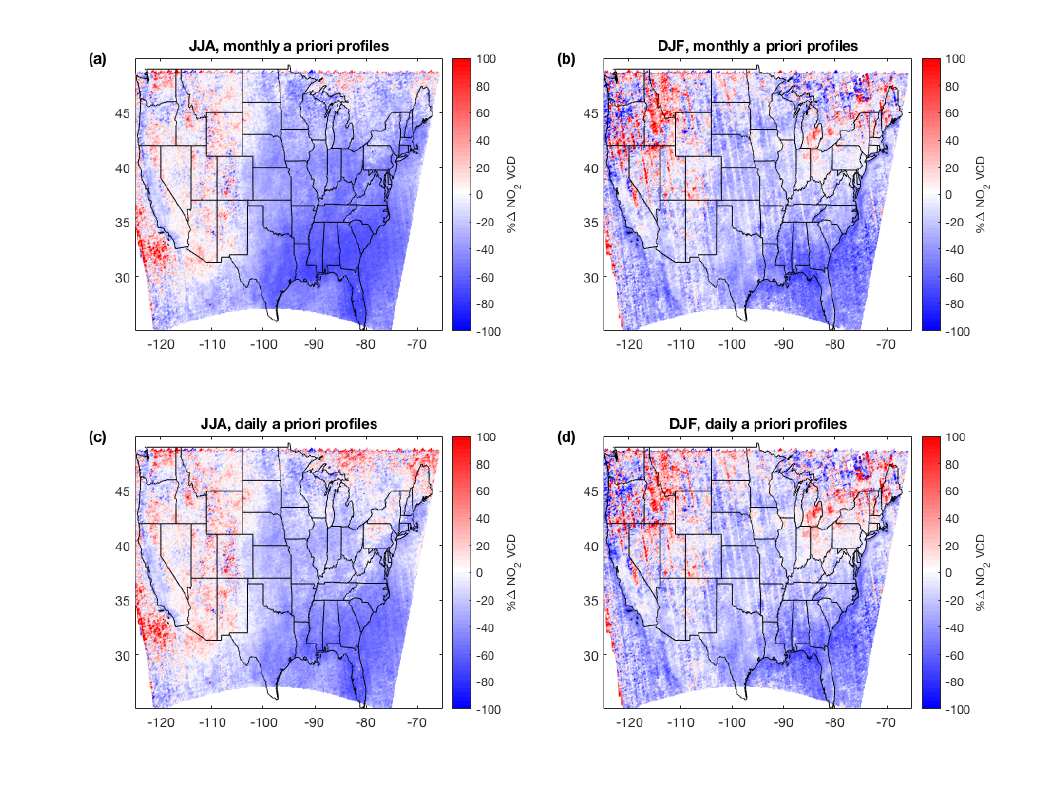
Figure 6. Overall average differences in total tropospheric NO 2 VCDs between v2.1C and v3.0B for June–August (a, c) and January, February, December (b, d) of 2012. (a, b) using monthly NO 2 profiles in v3.0B, (c, d) using daily profiles in v3.0B.